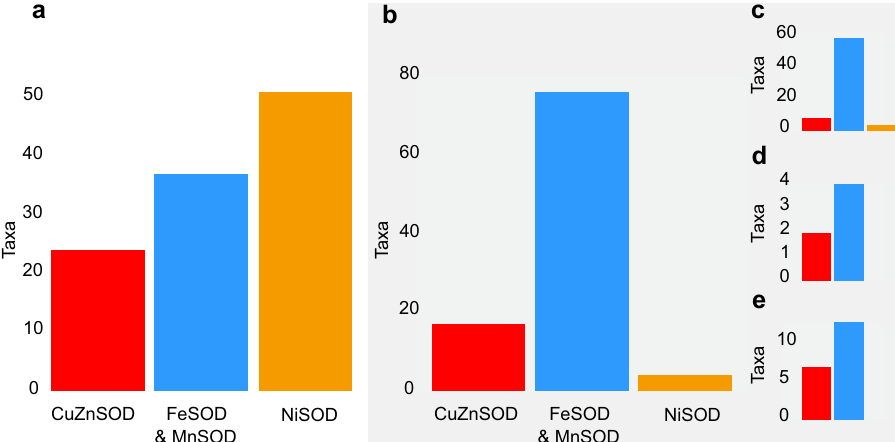
Fig. 2 Habitat distribution of SOD genes. Panels represent the distribution of CuZnSOD (red), NiSOD (orange), and Fe- and Mn-utilizing SODs (blue) in cyanobacteria from a marine and b non-marine habitats. Non-marine habitats include c freshwater, d geothermal springs, and e terrestrial